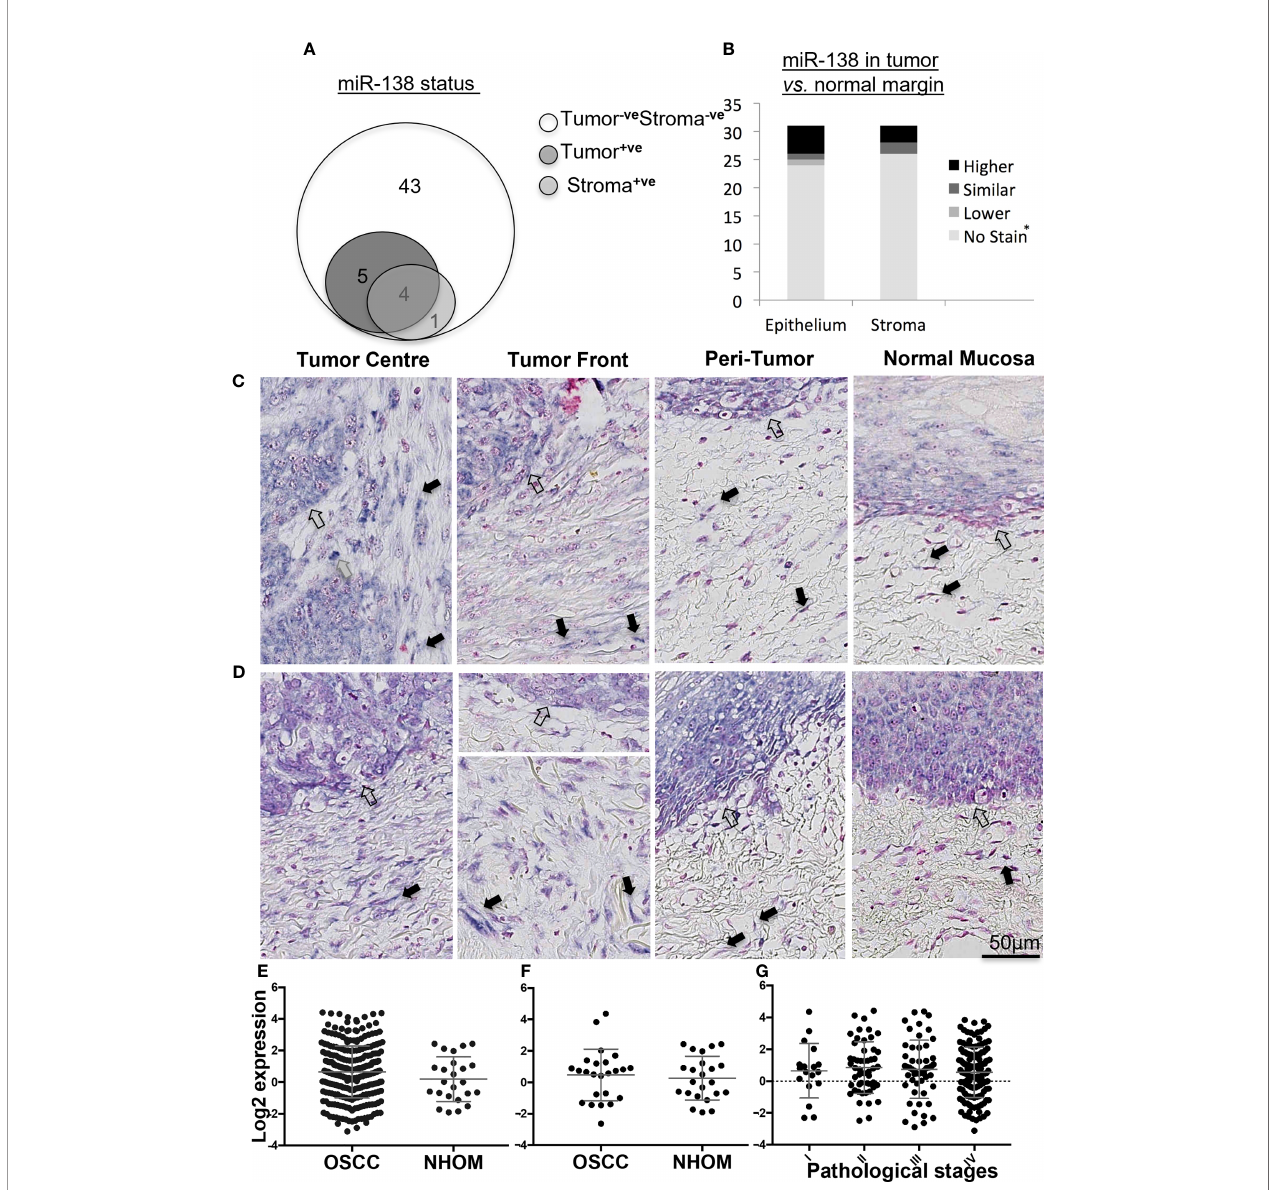
FIGURE 1 | Expression of miR-138 in OSCC. (A) Venn diagram showing distribution of OSCC cases according to miR-138 staining positivity in the epithelial and tumor-associated stroma regions. (B) Stacked bar plot comparing the miR-138 expression in epithelial and stromal compartments in the OSCC lesions compared to peritumoral/normal margins. * -ve Stain in both tumor and adjacent normal/peritumor area. (C) Higher miR-138 expression in cancer cells in tumor center (TC) and tumor front (TF) compared to adjacent peritumor (PT) and normal (TN) areas. (D) Higher expression in PT region compared to TC and TF. Lymphocytes, fi broblasts, and epithelial/malignant compartment in gray, black, and un fi lled arrows, respectively. (E) TCGA miR-138 expression in between OSCC and matched NHOM, (F) OSCC and unmatched NHOM, and (G) among pathological stages in OSCC. Unpaired t -test, paired t -test, and one-way ANOVA, respectively, for (C – E)